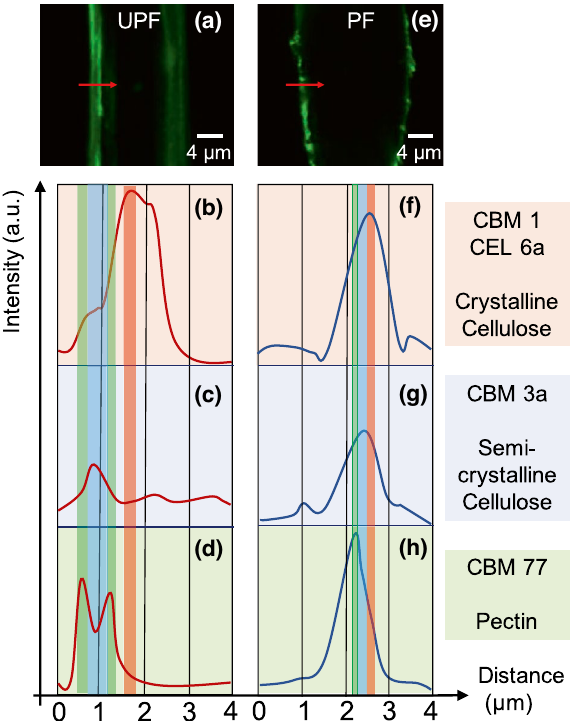
Fig. 7 a Image slice of the confocal fluorescence imaging of a UPF. The intensity peaks over the distance of the CMBs in the UPF are shown in b for CBM1Cel6a, in c for CBM3a and in d) for CBM77. In e , an image slice of the confocal fluorescence imaging of a PF is shown. The intensity peaks over the distance of the CMBs in the PF are shown in f) for CBM1Cel6a, in g for CBM3a and in h for CBM77. The peaks of the corresponding CBMs are marked in the green (CBM77), blue (CBM3a) and red (CBM1Cel6a)